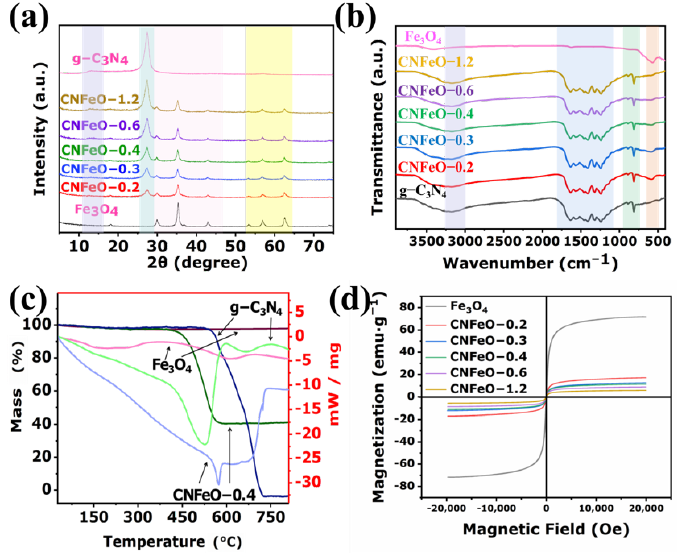
Figure 2. ( a ) XRD patterns and ( b ) FT-IR patterns of Fe 3 O 4 , g-C 3 N 4 , and different ratio g-C 3 N 4 @Fe 3 O 4